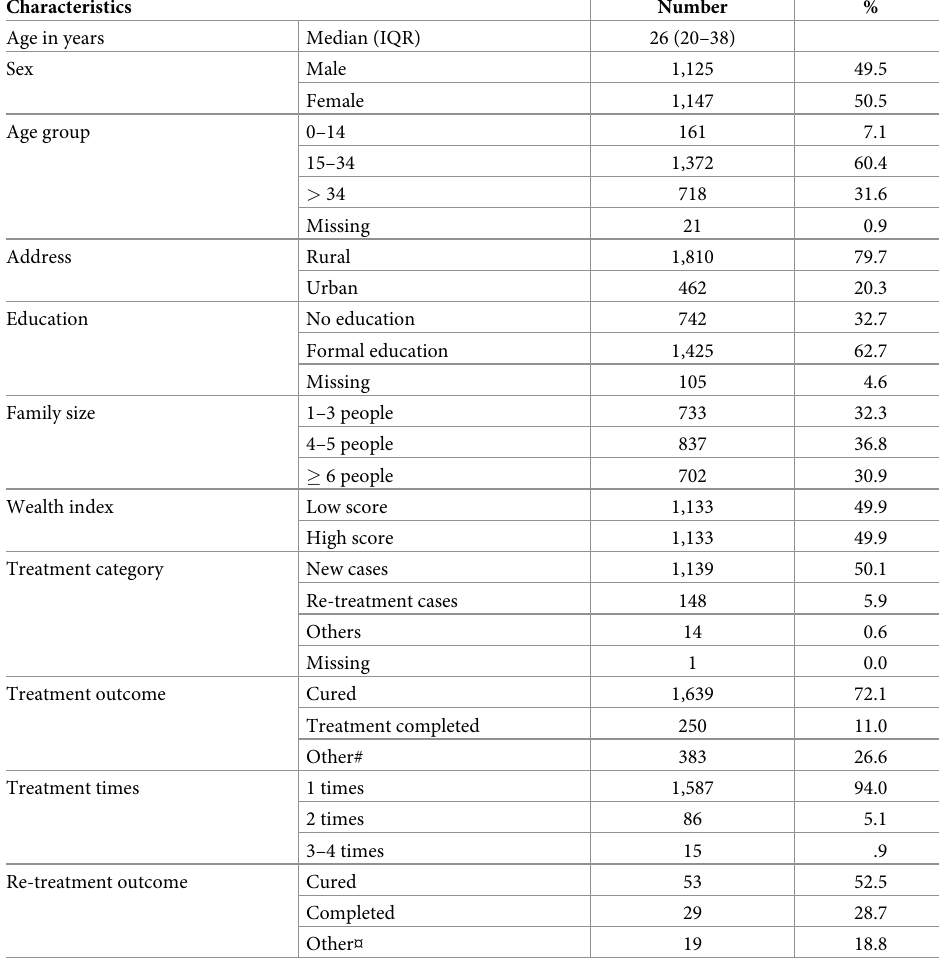
Table 1. Baseline and clinical characteristics of TB patients in Dale district, South Ethiopia.